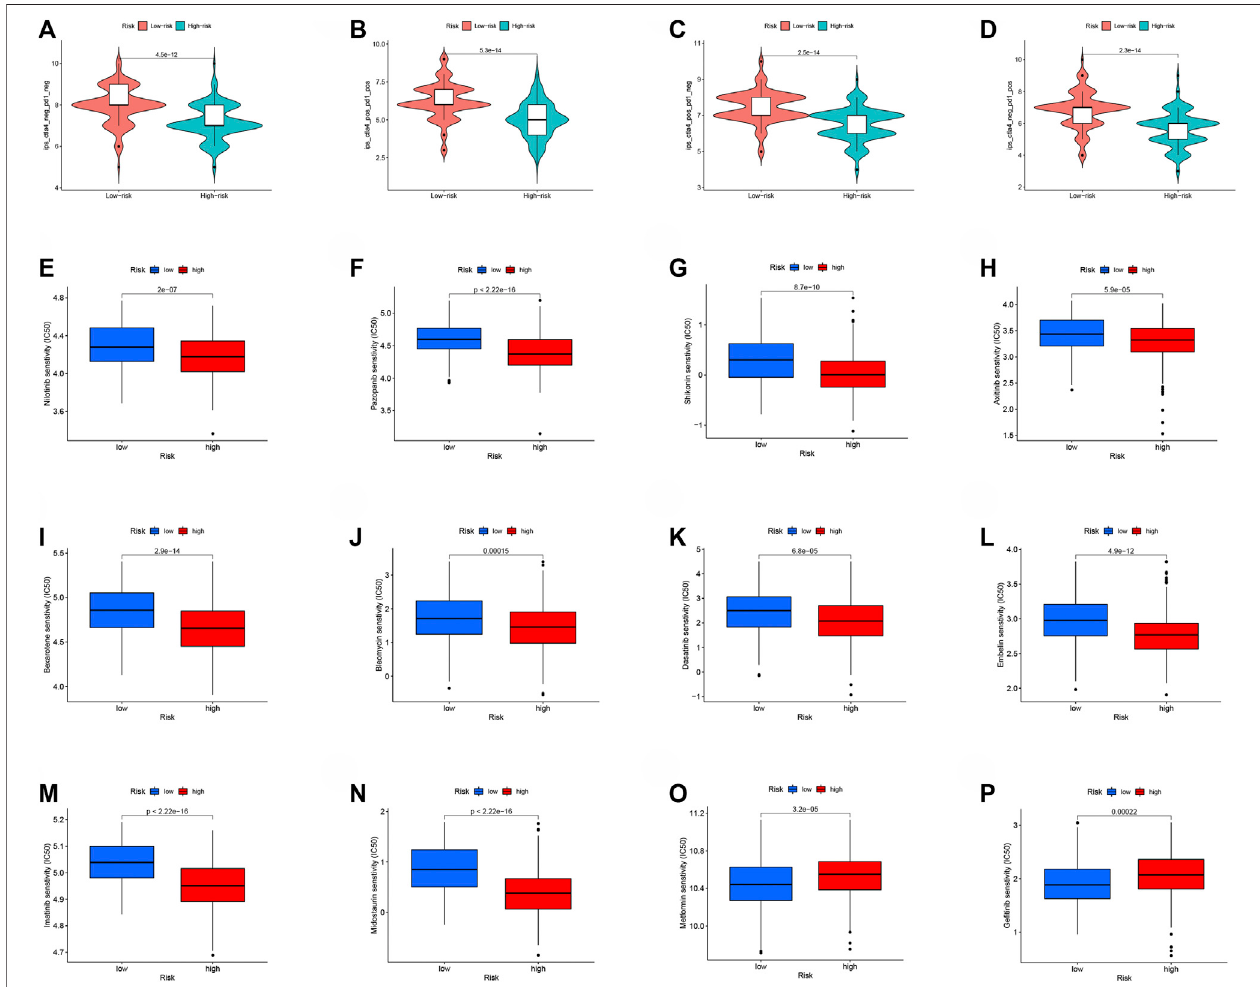
FIGURE 8 | Application of RS in immunotherapy and chemotherapy of OC patients. Immunotherapy in patients with high- and low-RS groups (A) CTLA4 − PD1 − ; (B) CTLA4+ PD1+; (C) CTLA4+ PD1 − ; (D) CTLA4 − PD1+. Analysis of drug sensitivity in high- and low-RS groups (E – P) .